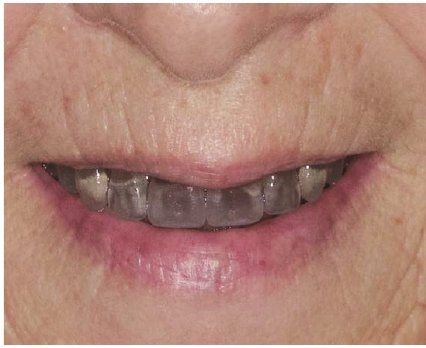
Figure 8: Clinical evaluation of the first prototype.